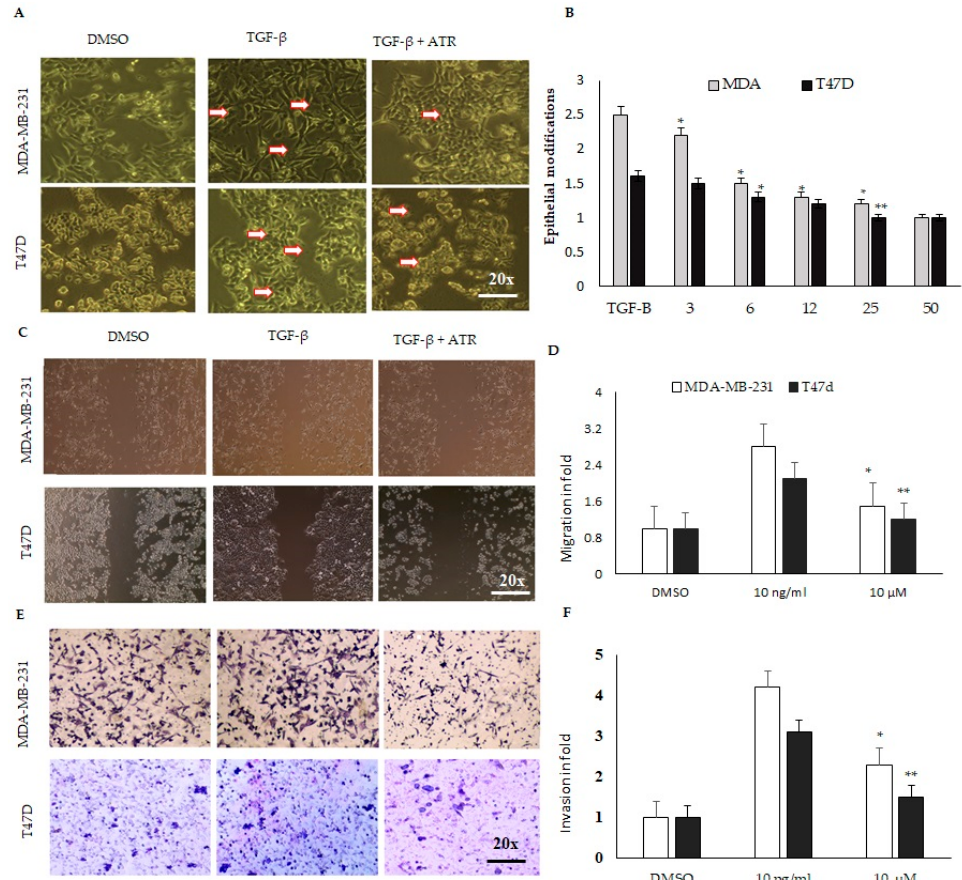
Figure 4. Atropine abrogates the cancer stem cell modifications in breast cancer cells. ( A ) MDA-MB-231 and T47D cells were treated with TGF- β challenged with atropine and the cellular structural modifications are shown. The phase-contrast microscopic images of control, TGF- β and TGF- β as well as atropine-treated cells. The red arrow mark indicates the mesenchymal modification from epithelial structure (TGF- β ) and retained in atropine treatment. ( B ) MDA-MB-231 and T47D cell monolayers in 6-well plates were scratched down and wells were supplemented with TGF- β and TGF- β as well as atropine for 24 h. The migration was observed with an optical microscope (200× magnification) for recording wound-healing activity. ( C ) MDA-MB-231 and T47D cells treated with TGF- β and TGF- β as well as atropine to the upper chambers of Matrigel-coated transwells, and invasion was inspected via total cell counting in reversal plot of transwell. Cells crossed to the lower chamber after 24 h. The inhibition percentage of invasion was quantified and is expressed relative to the control (untreated cells), whose level of invasion was set at fold change. ( E ) Representative images of the invasion activity of treated cells. The migration ( D ) and the invasion ( F ) activity of breast cancer cell lines treated with DMSO, TGF- β (10 ng/mL) or TGF- β (10 ng/mL), and atropine 10 µ M. Results are shown as mean ± SD from a representative experiment out of three independent experiments studied in quadruplicates and produced similar results. * p < 0.05 and ** p < 0.01 (one-way ANOVA); horizontal bars denote statistical